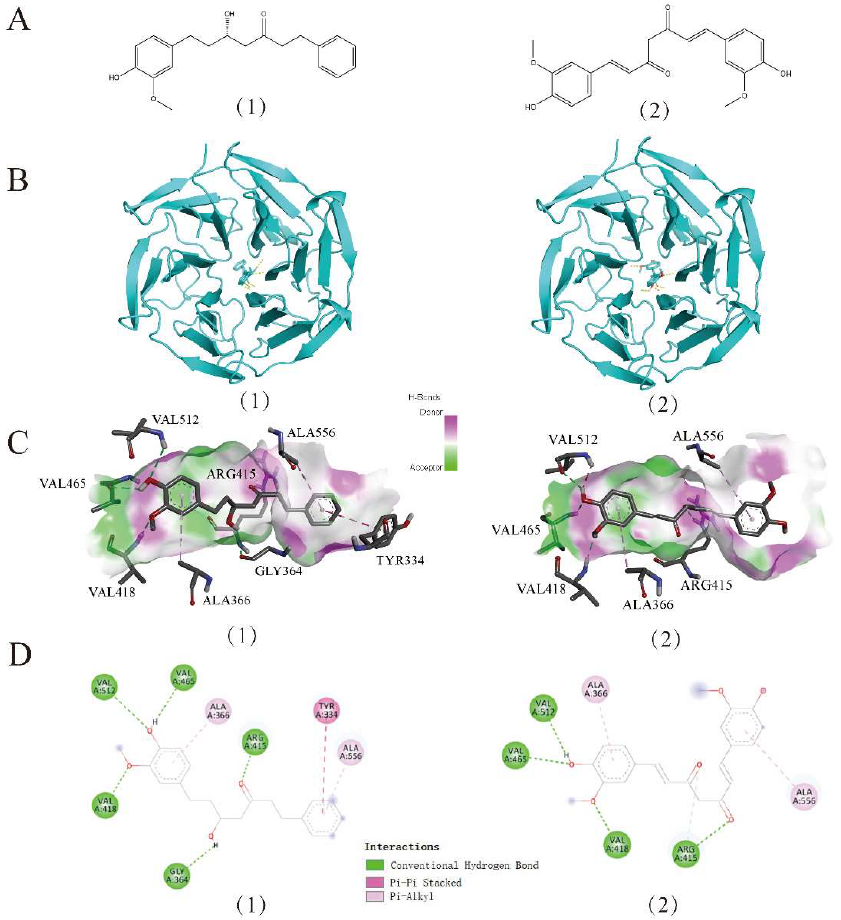
Figure 8. Docking between Keap1 (1X2J) and two compounds, DHPA (1) and curcumin (2). Molecular structure diagram of DHPA and curcumin ( A ). Global graph of docking results ( B ). The best binding pose, site view, and interaction graph between DHPA, curcumin, and active sites of Keap1 ( C , D ).